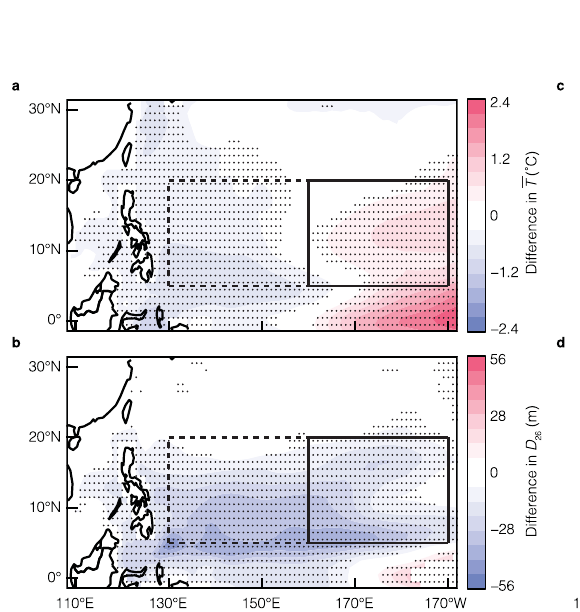
-- T )and26°Cisothermdepth( D (cid:3) Δ D Δ D Fig.3|Differencesoftheuppermixedlayer( NiñoandLaNiña. d ∂ GPI ∂ 26 ) 26 ,where 26 isthedifferencesof D 26 betweenElNiño D 26 betweenthetwophasesofENSOandtheirimpactsontropicalcyclonegenesis andLaNiña;thisrepresentsthesensitivityofGPIto D 26 .Theblackdotsindicatethe (GPI). Differences of (cid:1) T ( a ) and D 26 ( b ) between El Niño and La Niña. The unit is °C differences that are statistically signi fi cant at the 95% con fi dence (cid:3) Δ (cid:1) T , where Δ (cid:1) T is the difference in mean (cid:1) T between El for (cid:1) T and m for D 26 . c ∂ GPI ∂ (cid:1) T